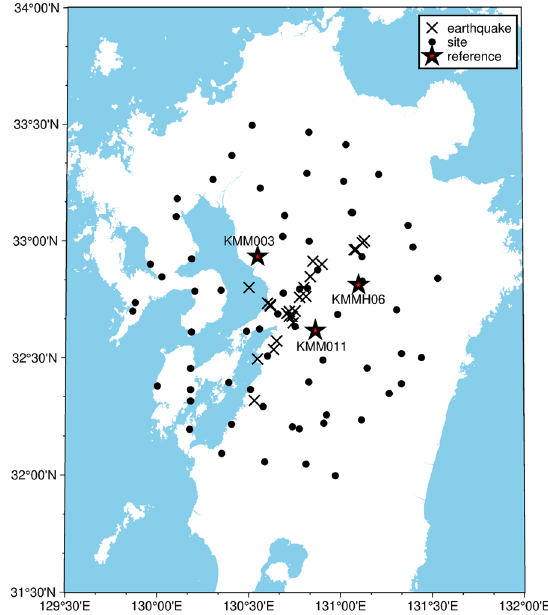
Fig. 2 Earthquakes and sites used in the spectral inversion for Q-value and site amplification factors. Black dots indicate the strong motion stations used in the inversion. Black crosses indicate the epicenters of the earthquakes used in the inversion. Red stars indicate the reference sites of the inversion